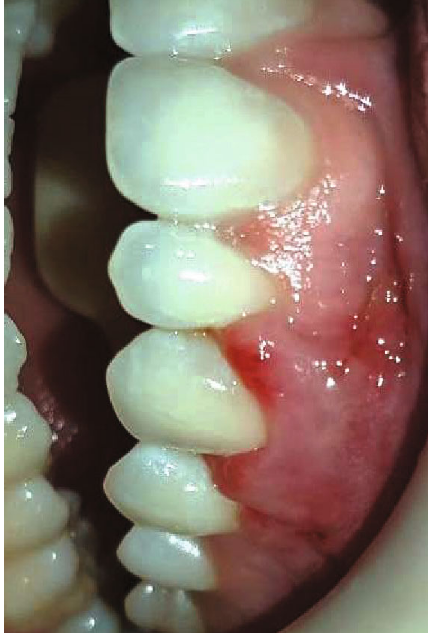
Figure 11: Removal of sutures 15 days